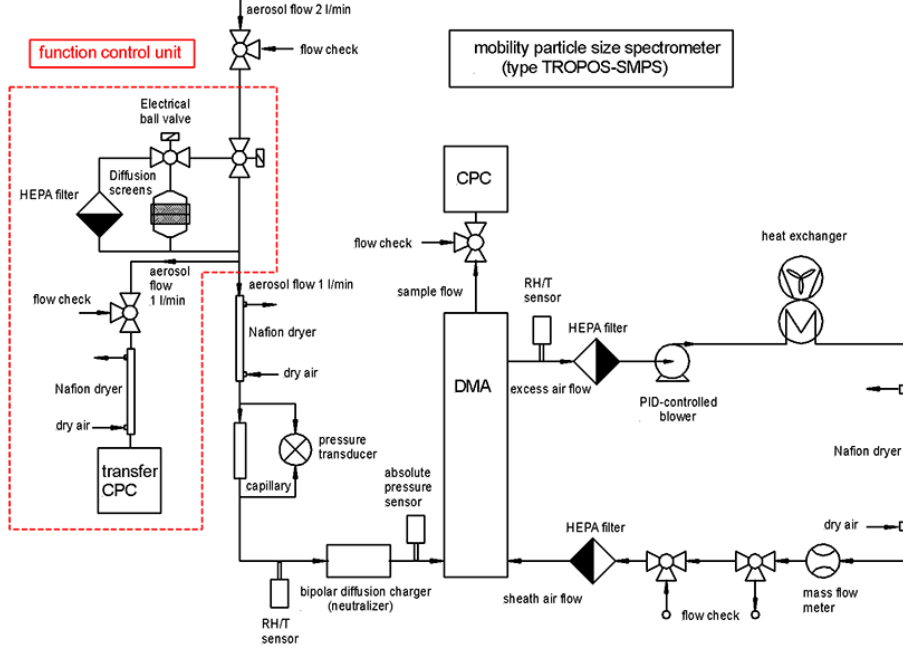
Fig. 1. Scheme of a closed-loop mobility particle size spectrometer equipped with an additional function control unit.